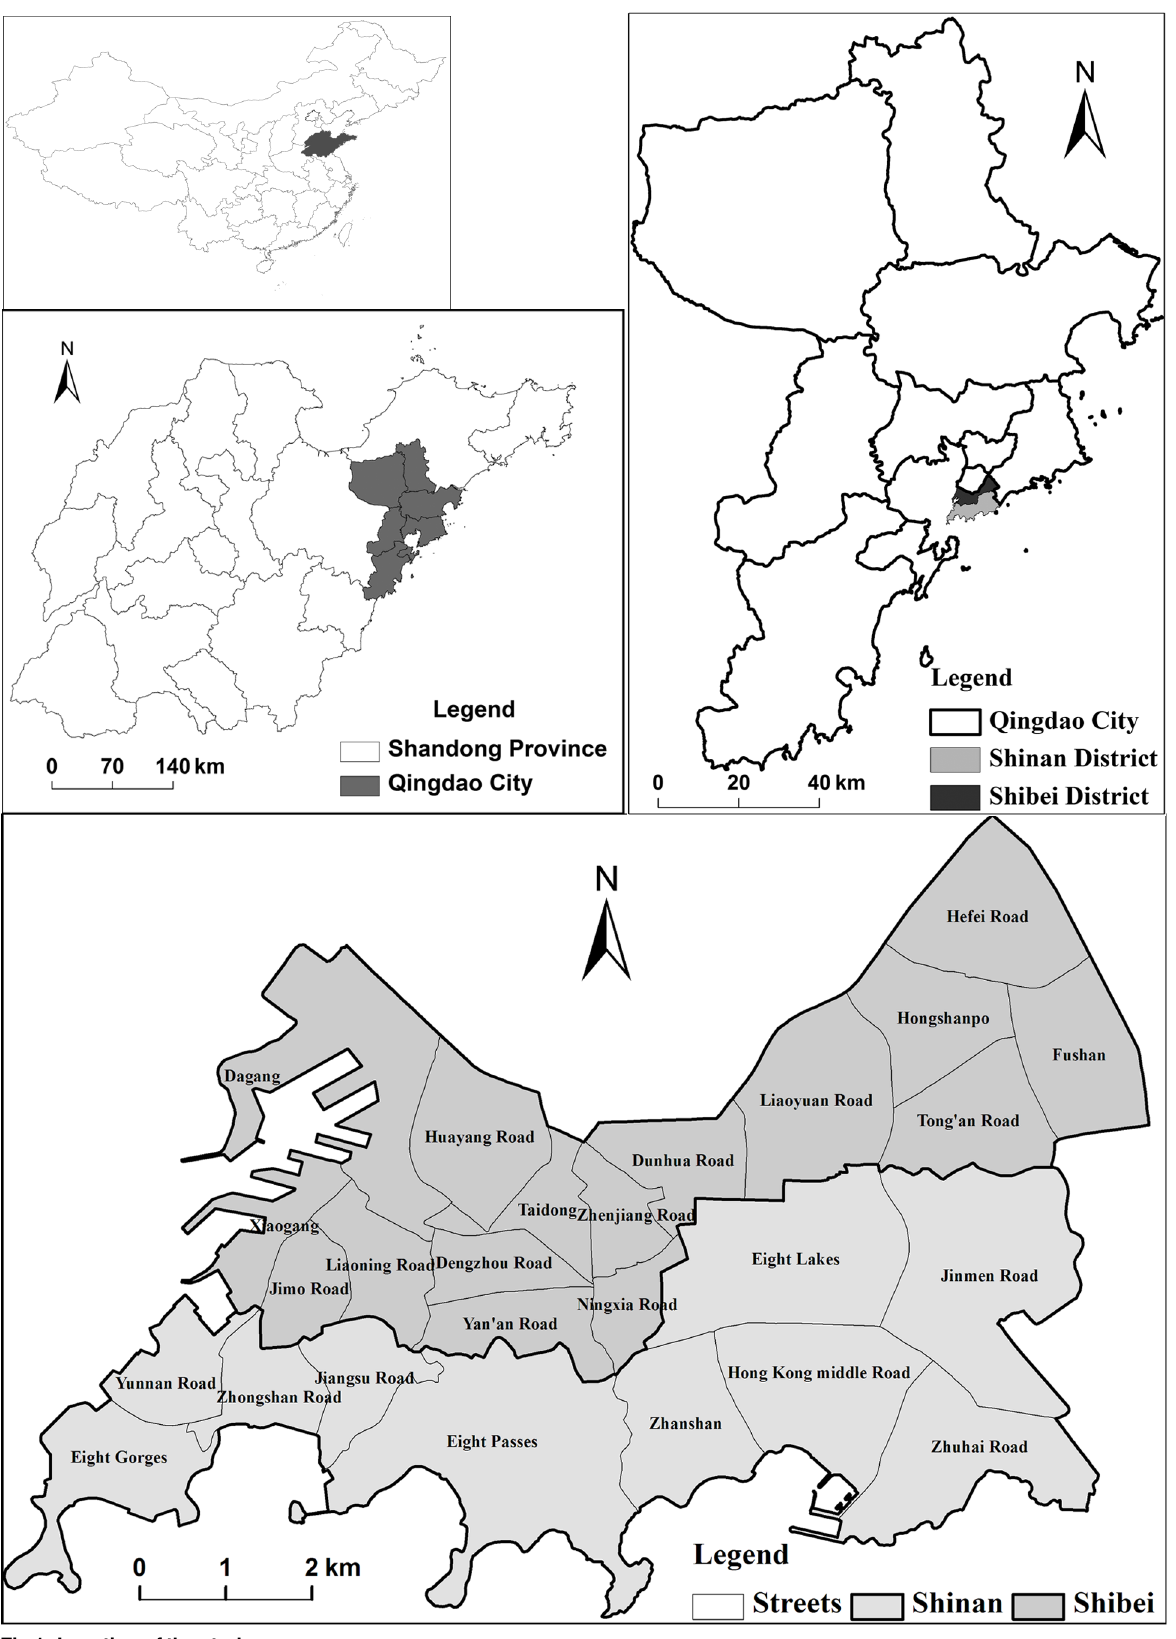
Fig 1. Location of the study